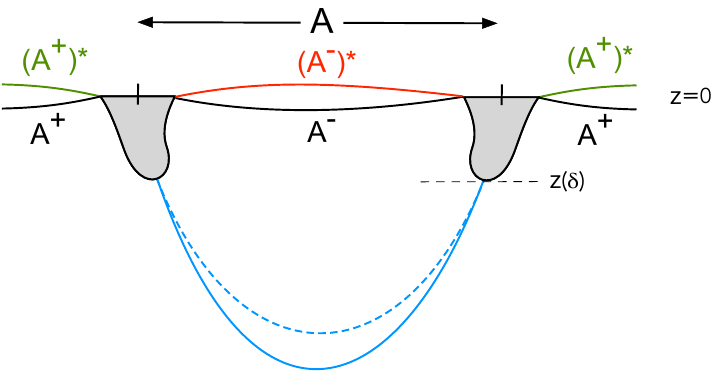
Figure 14 . AdS shown in Poincaré coordinates where z is the radial direction: A, A ± are boundary regions, with D ( A − ) ⊂ D ( A ) ⊂ D (( A + ) c ) . The entanglement wedge rr ? ( AB ) is the white region in the bulk, within which the reflected minimal surface is shown in blue. S R ( A − : A + ) / 2 obtained by this procedure approaches S EE ( A ) with the natural AdS regulator which cuts the minimal surface off at z = z ( δ )